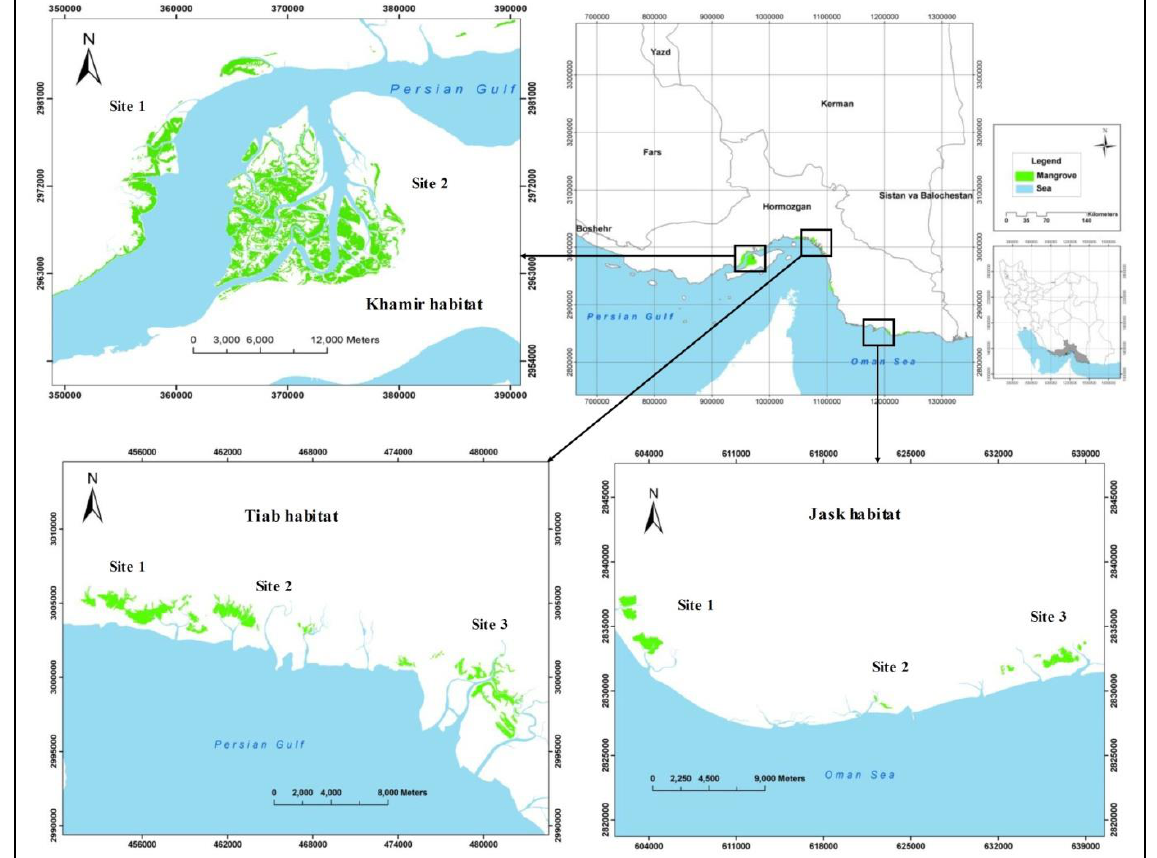
Figure 1. Geographic location of mangrove habitats on the northern coasts of the Persian Gulf and the Oman